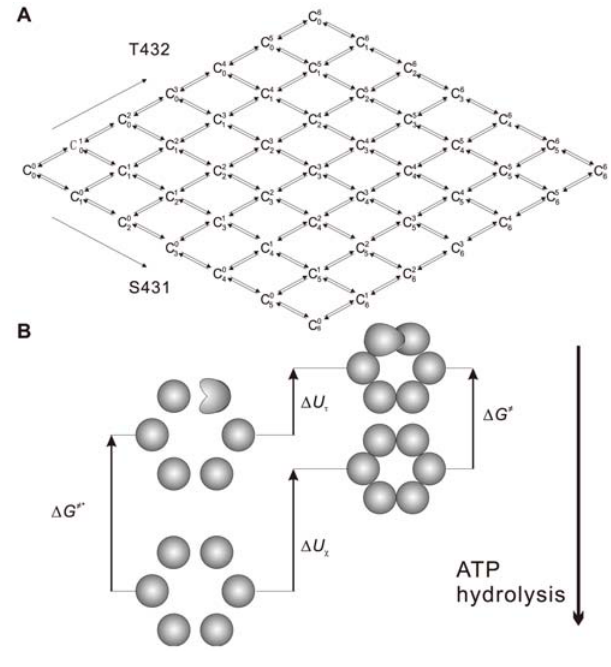
Figure 1. Fundamental schemes proposed in the model. (A) Reaction network for KaiC phosphorylation without KaiA and KaiB. The full multi-layer network can be found in Text S1 (section 1.1). (B) Thermodynamic box for analyzing the apparent free energy of activation in KaiC phosphorylation or dephosphorylation. On the left side, the six KaiC monomers are independent from each other. The subunit interaction that is driven by ATP hydrolysis results in the formation of stabilized and coordinated hexamers in ground state and transition state (on the right). ATP hydrolysis provides sufficient amount of extra negative free energy to make all the reactions and interactions thermodynamically possible.